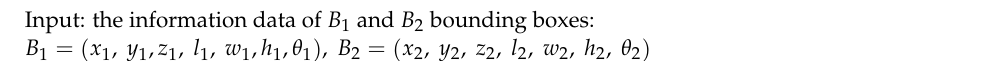
Algorithm 1. 3D Distance Intersection Over Union